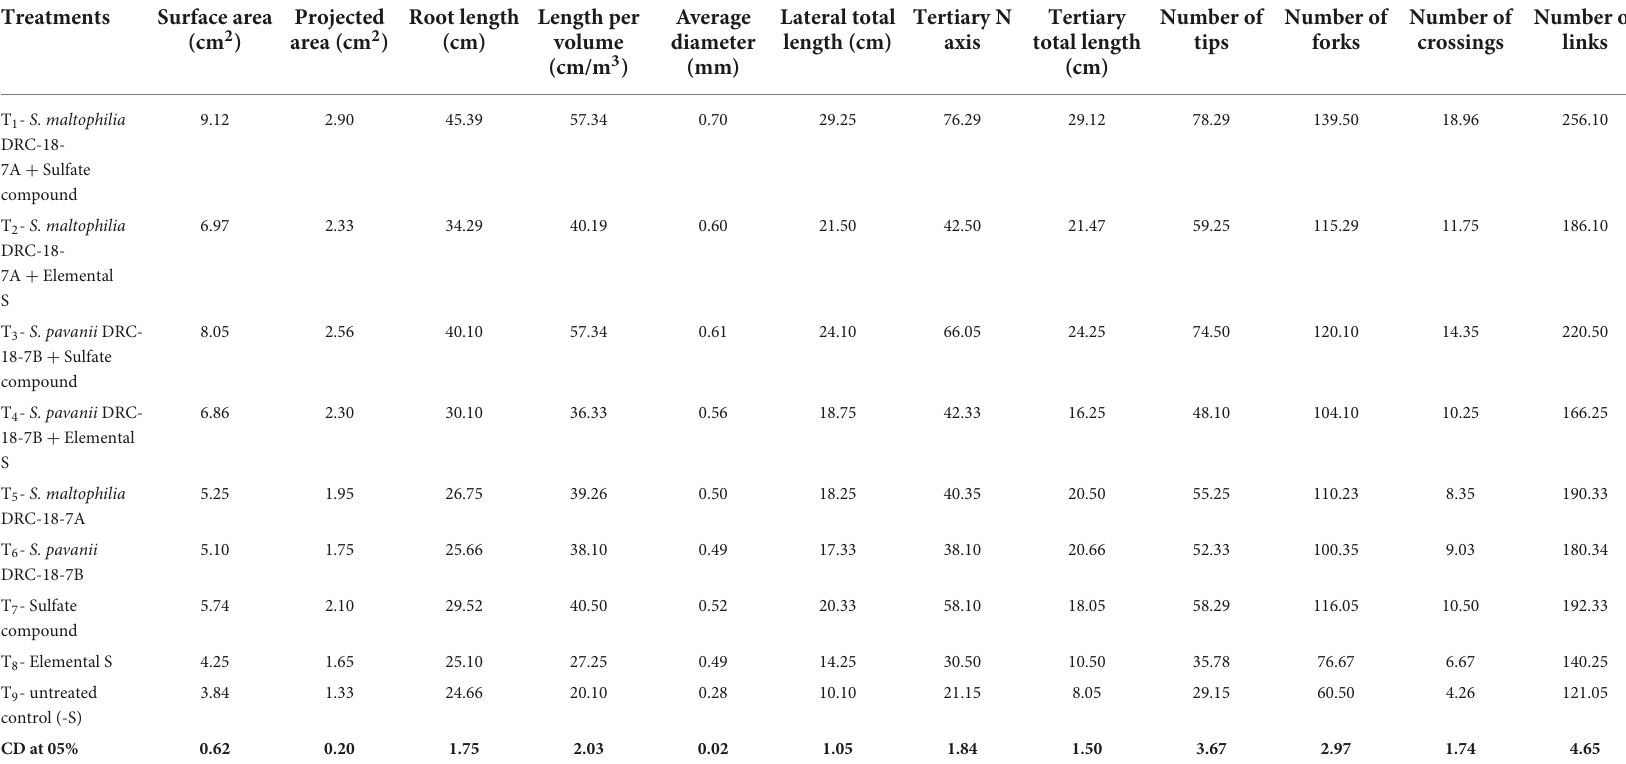
TABLE 2 Effects of inoculation on root architect and root development in pigeonpea leaves at 30 days of sowing under glasshouse conditions.